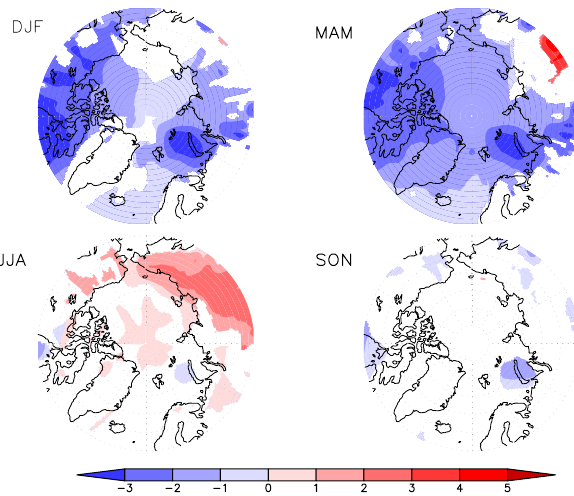
Fig. 12. Change in surface temperature ( ◦ C) north of 60 ◦ N from mid-Holocene to pre-industrial in the HadGEM2-ES, for winter, spring, summer and autumn. Only changes statistically significant at a 95% confidence level are shown. A clear warming can be seen for all seasons in the mid-Holocene climate.